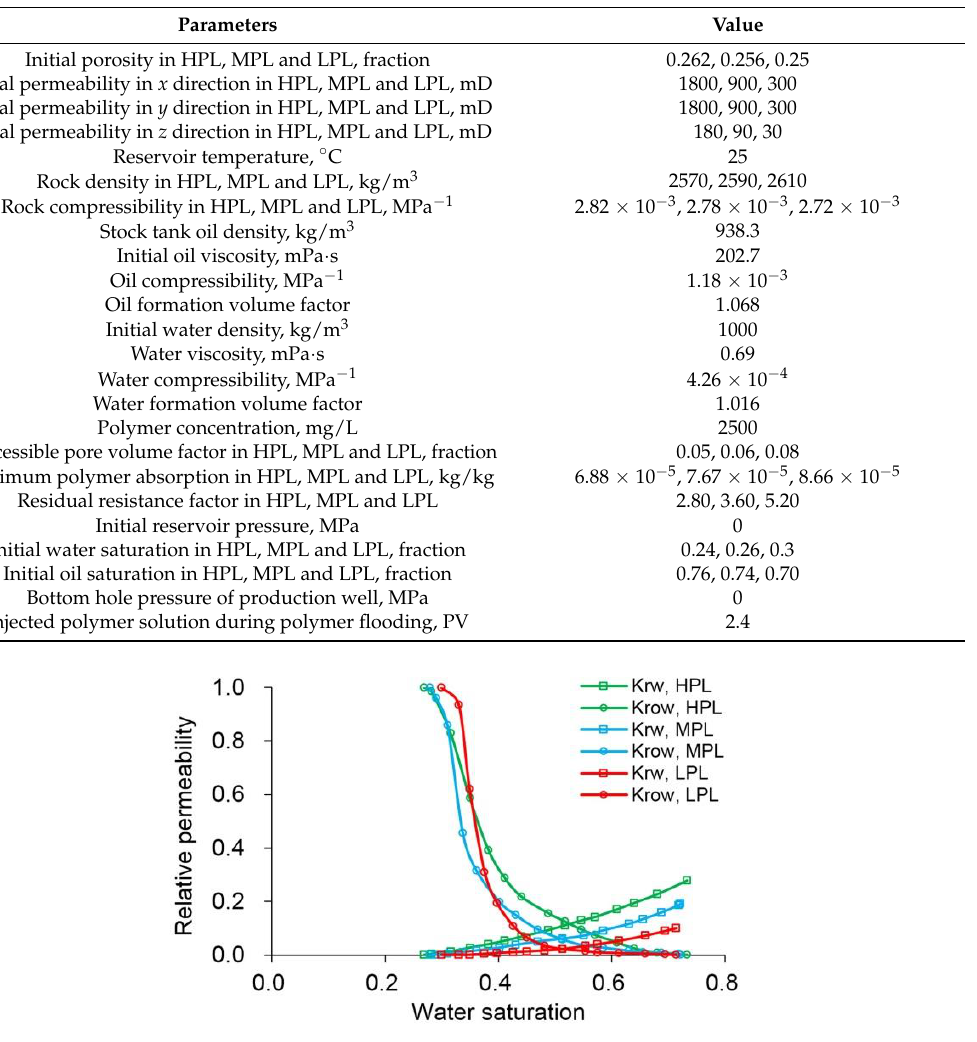
Table 7. The reservoir property, fluid property, initial conditions and production data of Case 1.